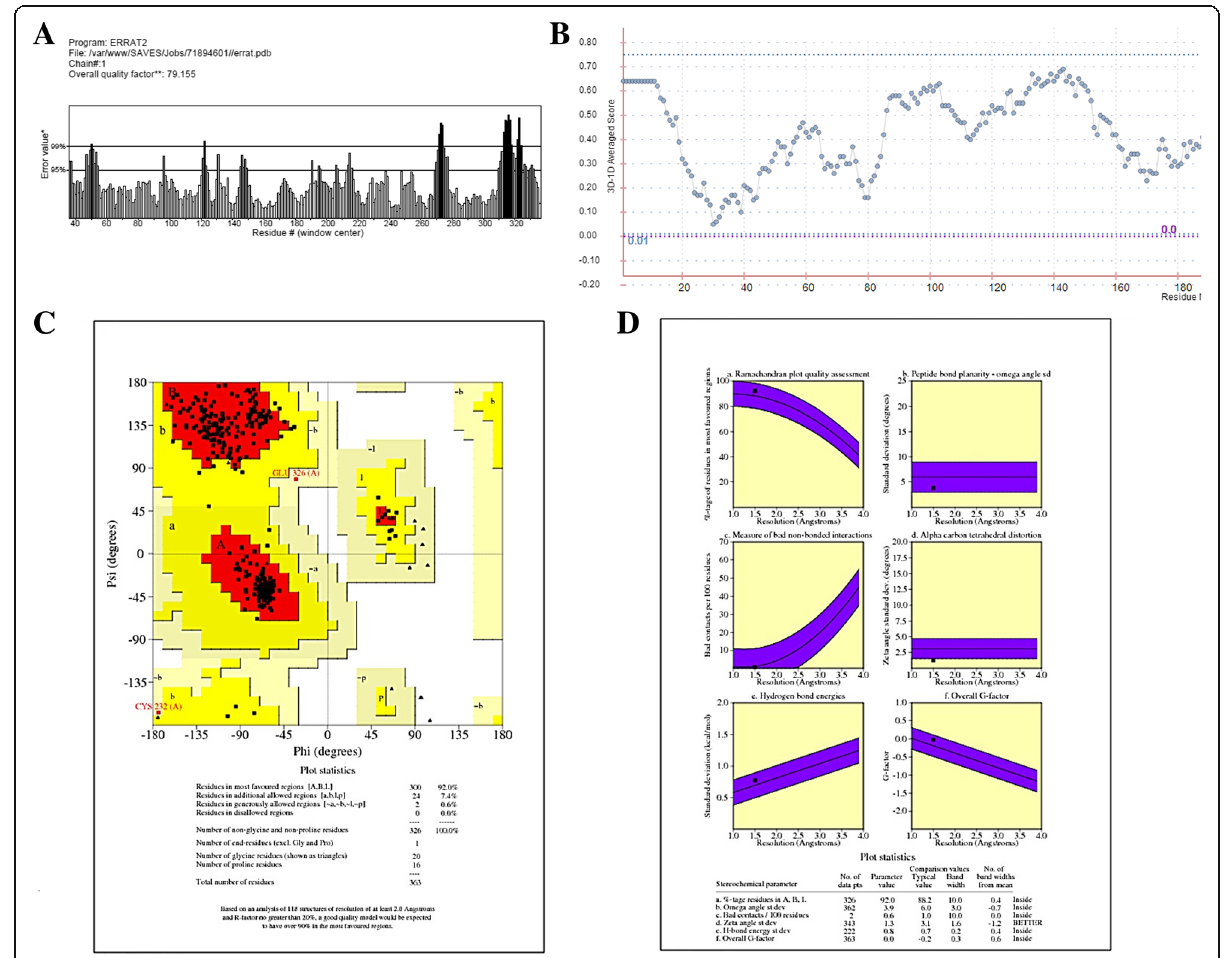
Fig. 2 Validation results for the predicted structure of NMDAR in humans. a Graphical representation of results from ERRAT. b Graphical representation of results from Verify_3D. c Ramachandran Plot for NMDAR (humans). d Main chain